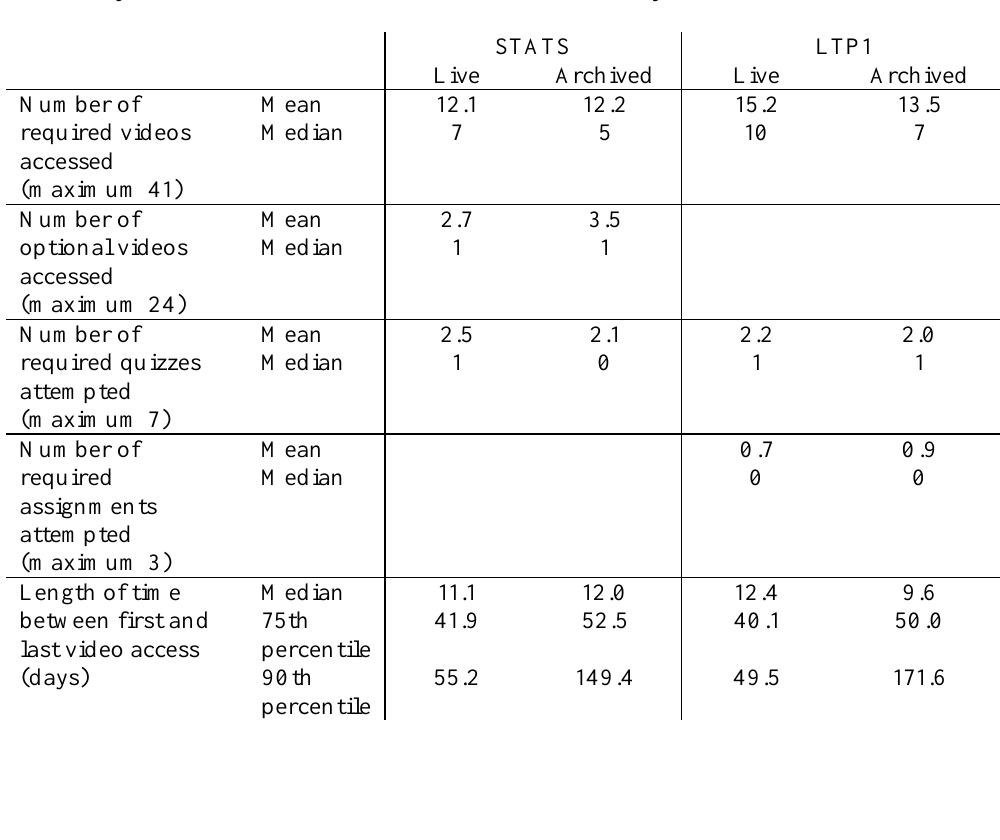
Table 2 Summary Statistics of Live and Archived Learner